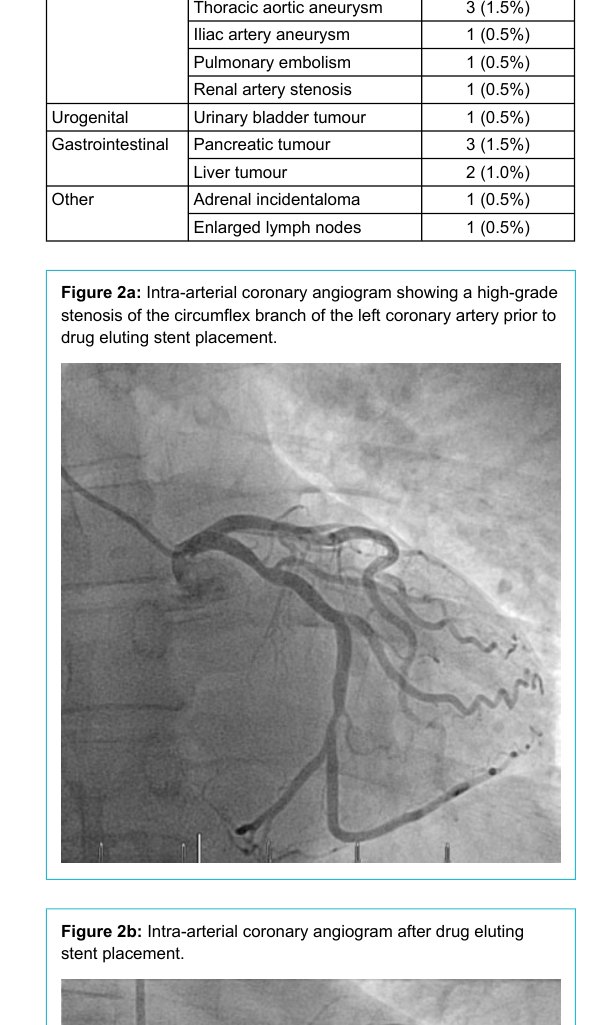
Figure 4: Axial CT scan of a bladder tumour incidentally diag- nosed in a 62-year old ED patient with a history of cigarette smok- ing and cerebrovascular